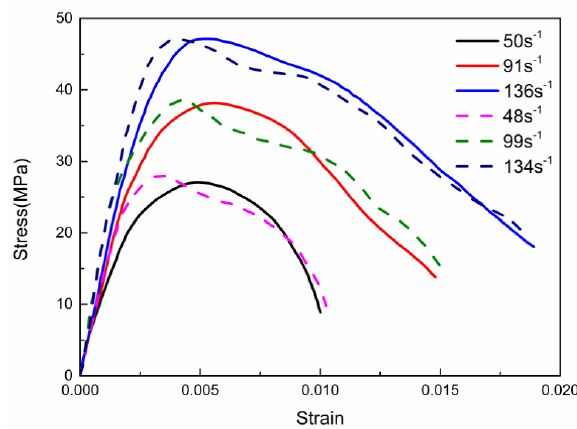
Figure 9. Stress–strain curves of the experiment and simulation with solid lines depicting the experimental curves and dashed lines representing numerical curves.